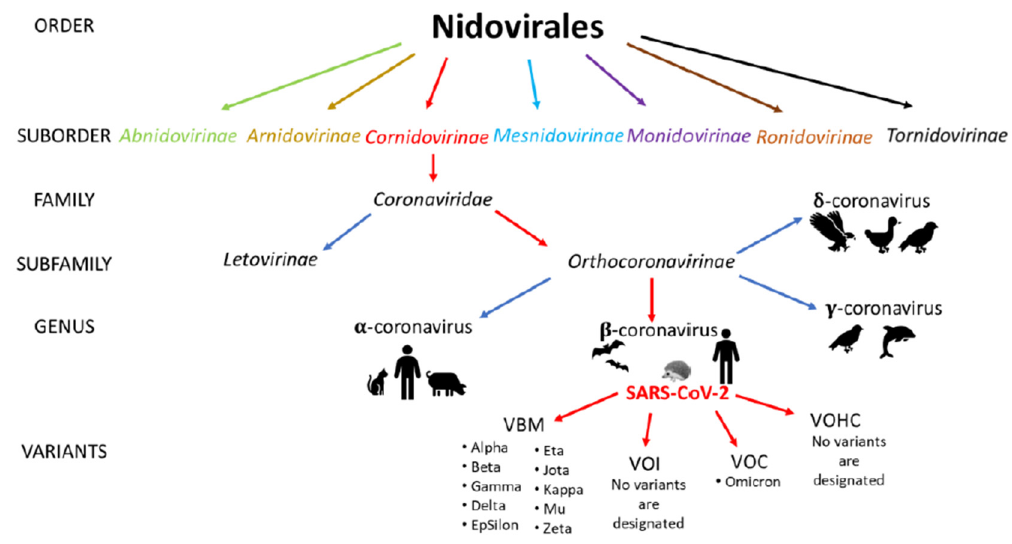
Figure 2. Virus classification (VBM—Variants Being Monitored; VOI—Variant of Interest; VOC— Variant of Concern; VOHC—Variant of High Consequence).